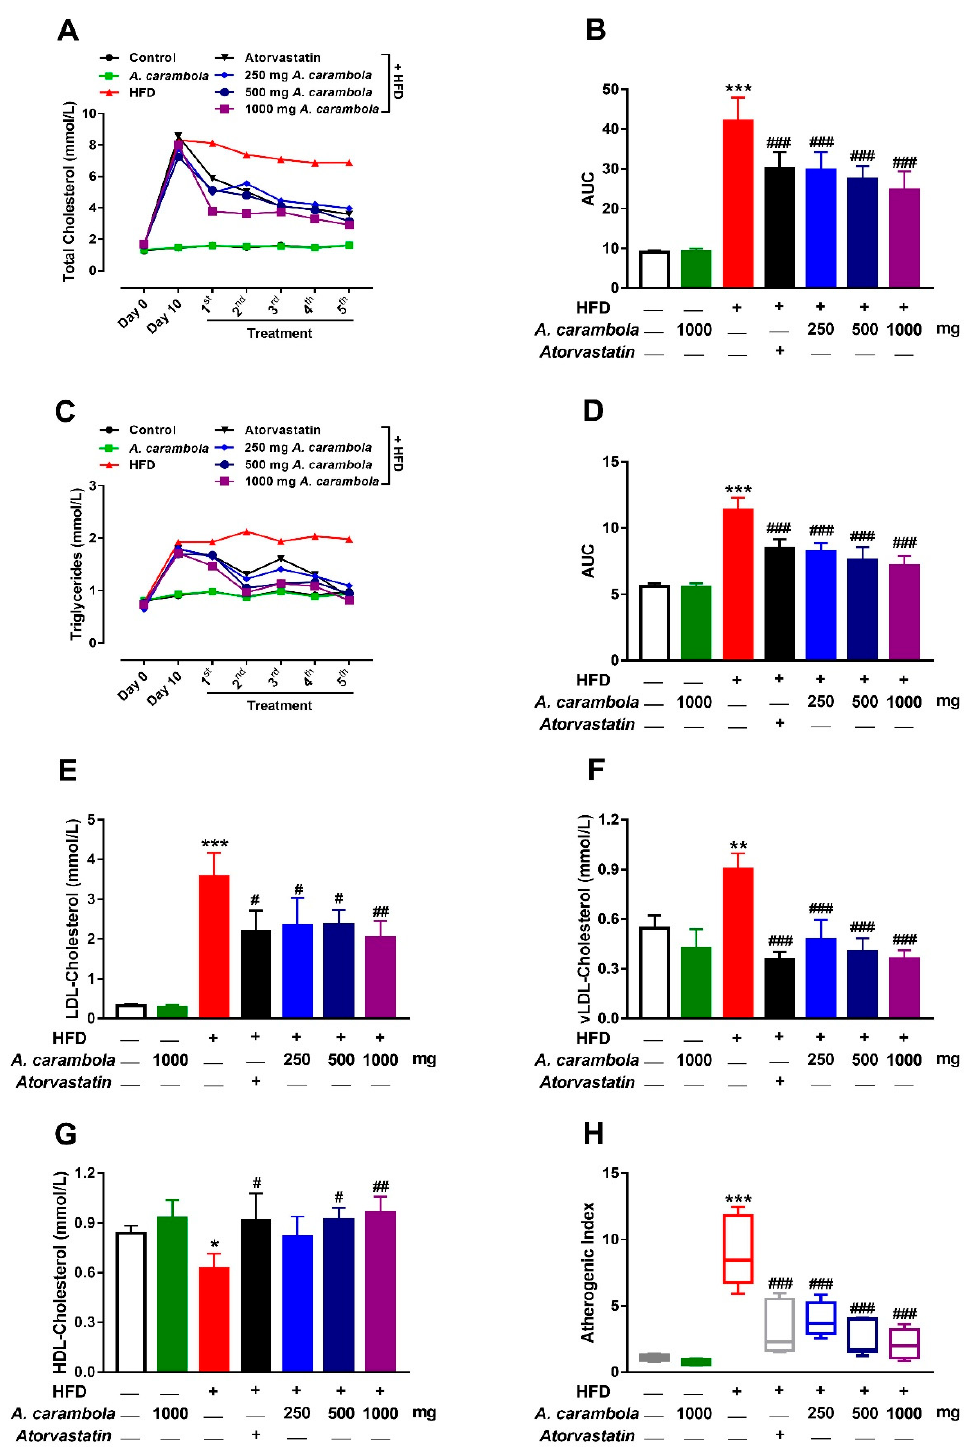
Figure 3. Effect of MEACL on levels of total cholesterol (TC) ( A,B ), triglycerides (TG) ( C,D ), low-density lipoprotein cholesterol (LDL-C) ( E ), very low-density lipoprotein cholesterol (vLDL-C) ( F ), high-density lipoprotein cholesterol (HDL-C) ( G ), and atherogenic index (AI) ( H ) of HFD-induced hyperlipidemic rats after five weeks of treatment. AUC, area under the curve. Values are expressed as mean ± SEM, n = 6. * p < 0.05, ** p < 0.01, *** p < 0.001 compared to normal control. # p < 0.05, ## p < 0.01, ### p < 0.001 compared to hyperlipidemic control. 3.4. MEACL Prevents HFD-Induced Histopathological Alterations